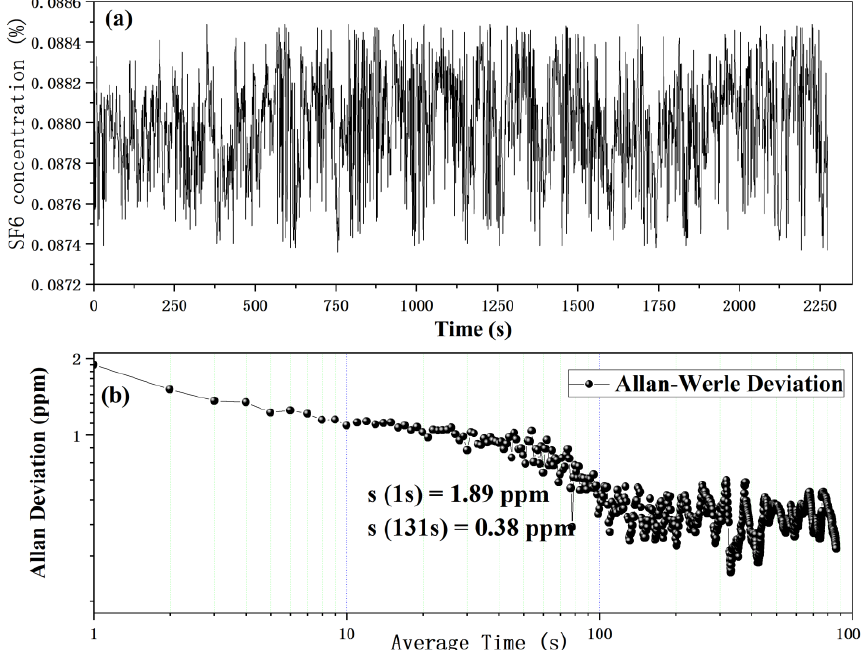
Figure 9. ( a ) Time series concentration of SF6 continuously measured standard gas sample, ( b ) Allan– Werle deviation as a function of signal averaging